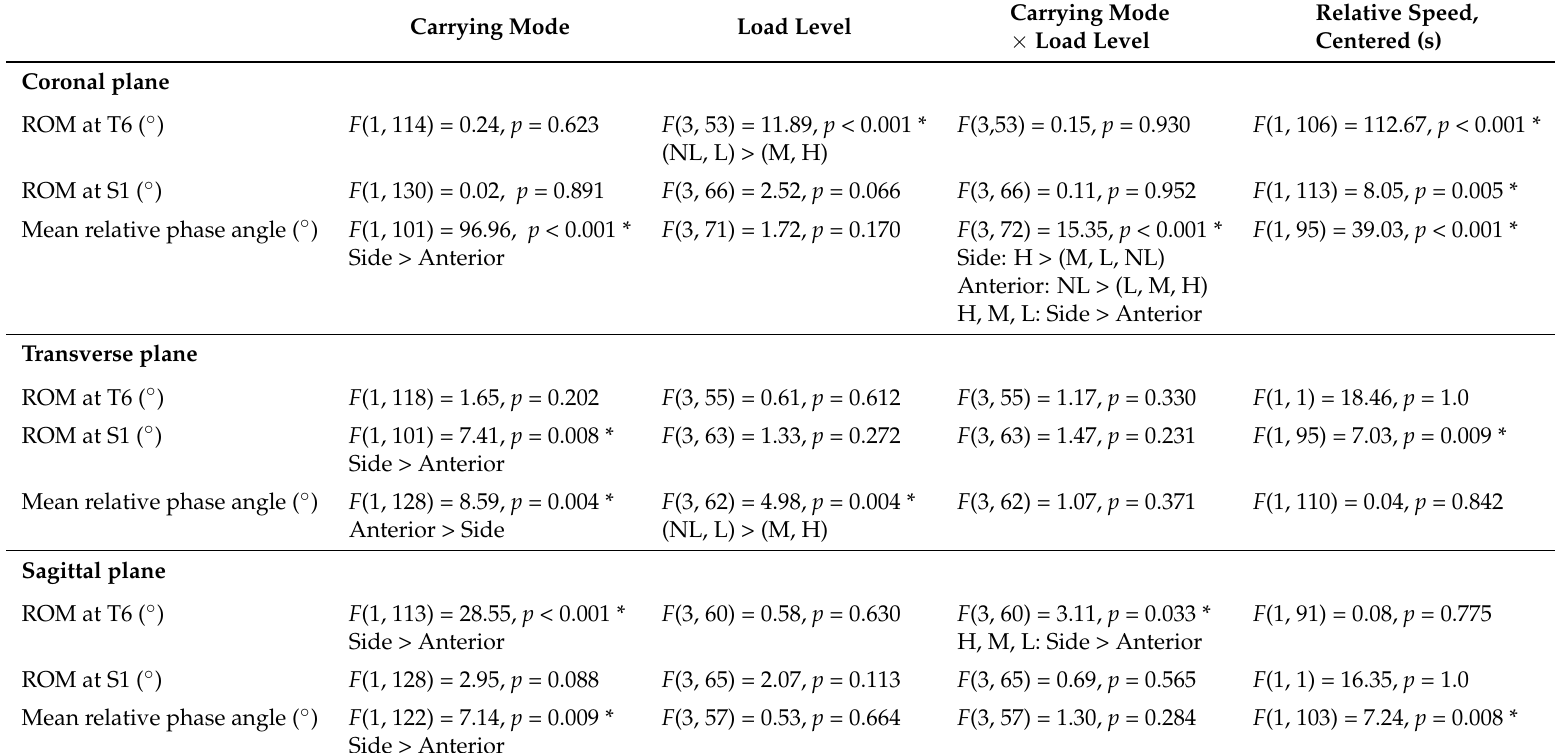
Table 2. Experiment-1 ( n = 9) summary results from the mixed effects analyses for the main and interaction effects of carrying mode and load level on torso and pelvis sway and thoracic-pelvic coordination measures in the coronal, transverse, and sagittal planes. Significant pair-wise Bonferroni comparisons ( p < 0.05) are provided for main and interaction effects that were significant at p < 0.05 indicated by *. NL = No-load (empty-handed), L = Low load at 4.5 kg, M = Medium load at 9.1 kg, H = High load at 13.6